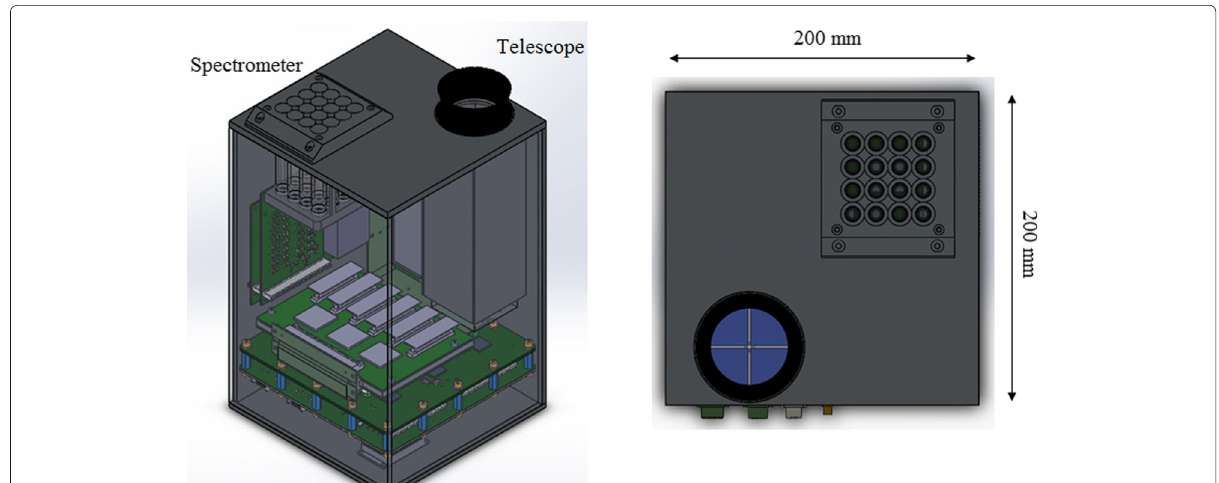
Fig. 6 Left: 3D model of the MLT. Right: a view of the top panel of MLT-S with entrance windows of the telescope and spectrometer. Entrance windows are directed to